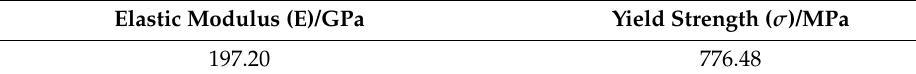
Figure 2. Parameters of the specimen’s geometry: ( a ) CT specimen size (thickness, 1.4 mm); ( b ) global crack image of the CT specimen; ( c ) digital speckle image of the CT specimen. Table 1. Material parameters for Q&P980.